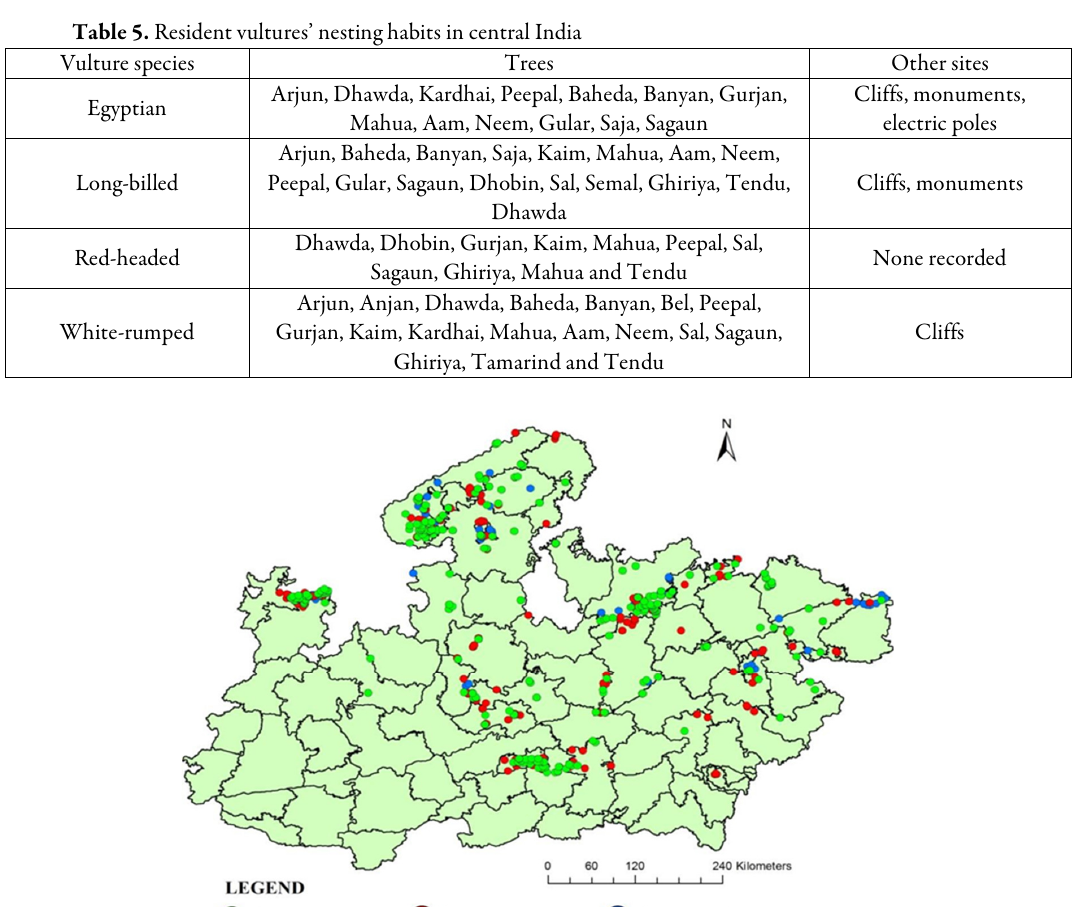
Figure 5. Spatial distributions of different categories of vulture nests found in Central India. Active nests (please note larger clusters of green circles) are mostly concentrated in Wildlife Protected Area